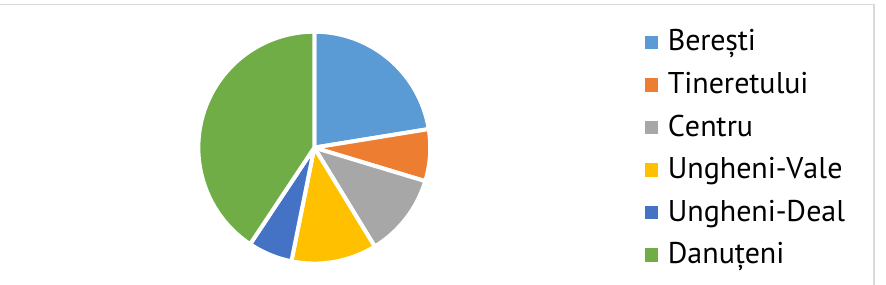
Figure 1. Sectors (micro-districts) of Ungheni